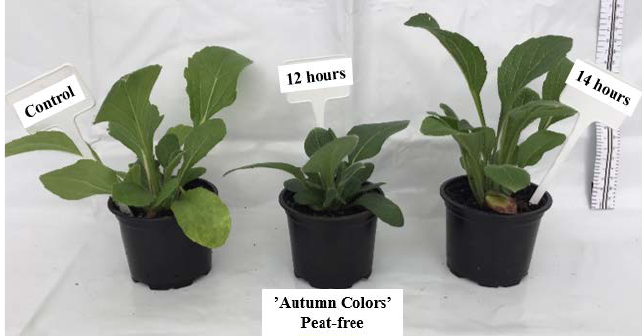
Figure 10. 11 weeks-old Rudbeckia hirta ‘Autumn Colors‘ plantlets depending on photoperiodic lighting treatments in peat-free media (University of Debrecen, Biological Research and Plant Experiment Greenhouse - Biodrome, Debrecen, Hungary,